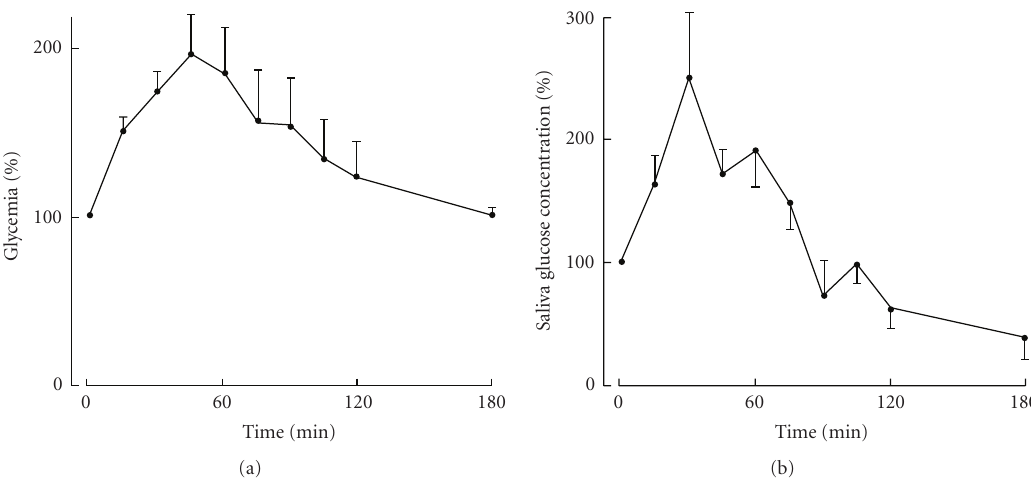
Figure 1: Time course for the changes in glycemia and unstimulated saliva glucose concentration in 4 normal subjects and 2 diabetic patients during an oral glucose tolerance test. Geometric mean values ( ± SEM) refer to results expressed in percent of paired basal value.